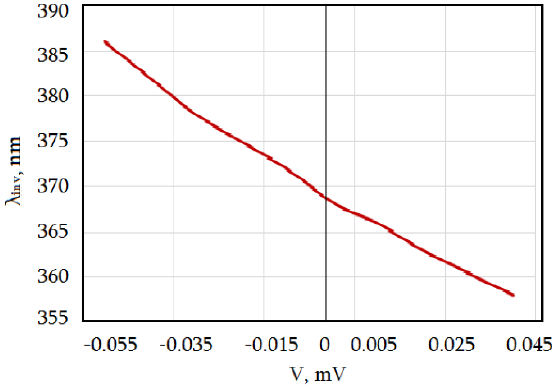
Figure 5. The dependence of the inversion point of the spectral photocurrent on the bias voltage.